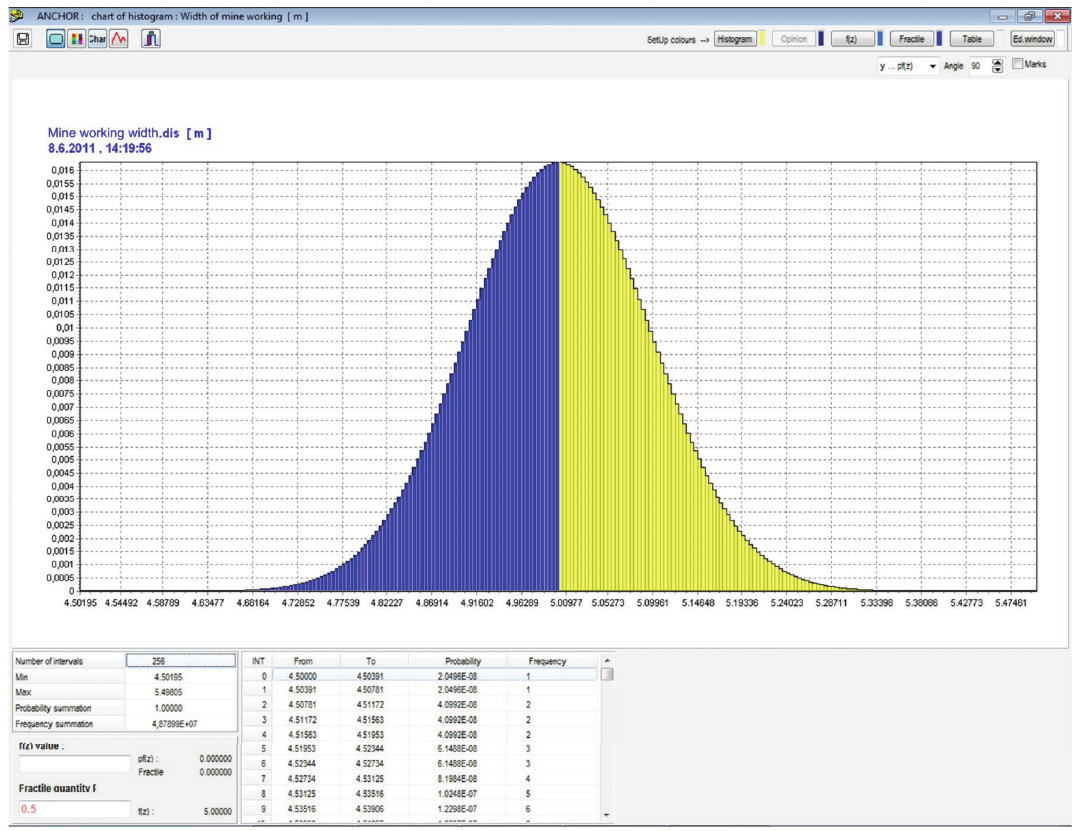
Figure 7: Histogram of the width of the mining working 𝐵 [m].